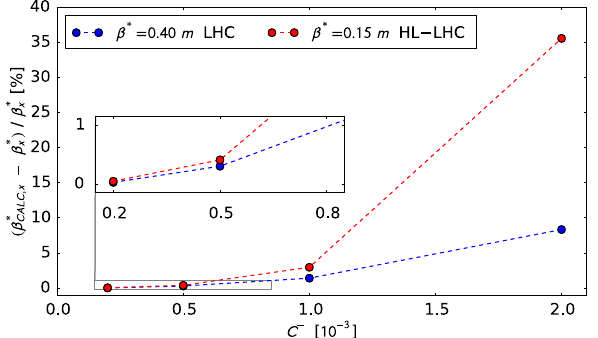
FIG. 9. Deviation of calculated β (cid:1) for different values of coupling for the LHC (top figure) and HL-LHC (bottom figure). Results show an increased deviation for increasing coupling in the accelerator.